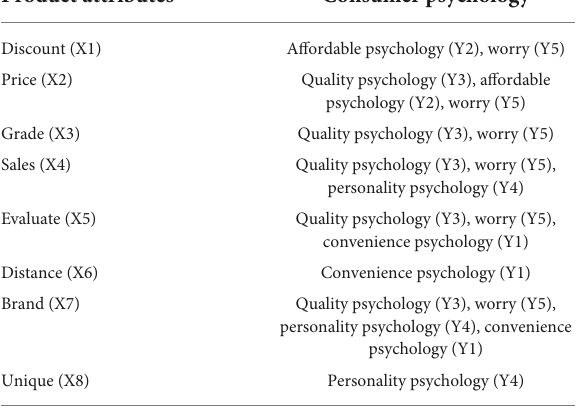
TABLE 5 Relationship between commodity attributes and consumer